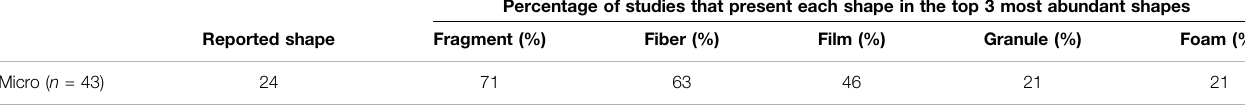
TABLE 5 | Count of microplastic shapes found in the top three most abundant shapes per study. Percentage of studies that present each shape in the top 3 most abundant shapes Reported